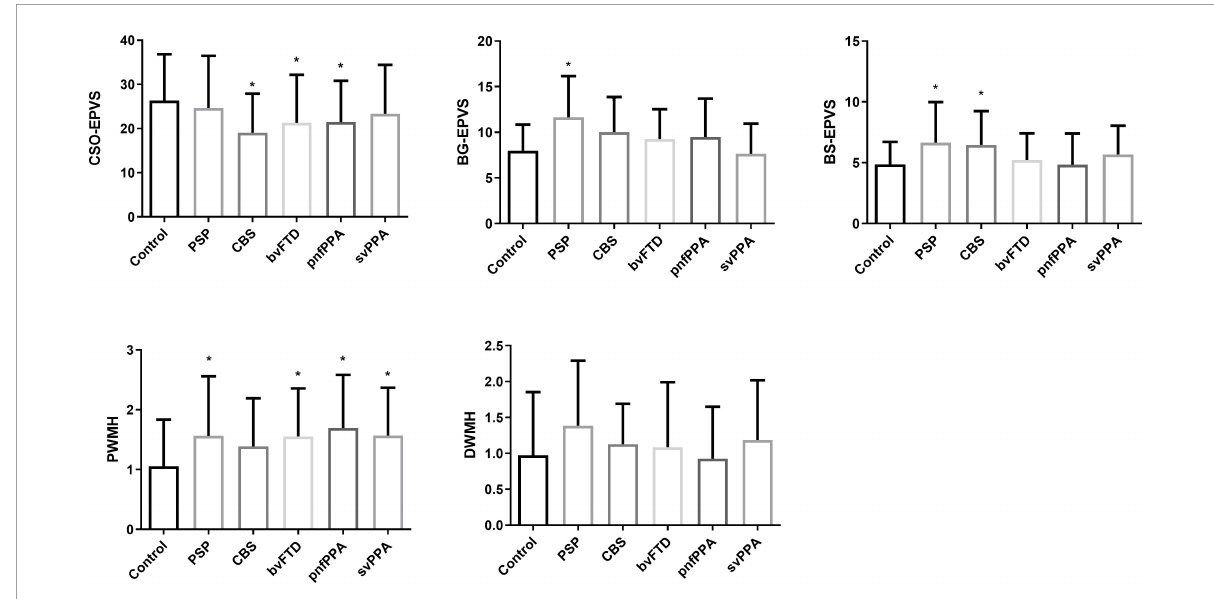
FIGURE2 Comparison of EPVS and WMH burden between the control and disease groups. * p < 0.05 compared with control group.